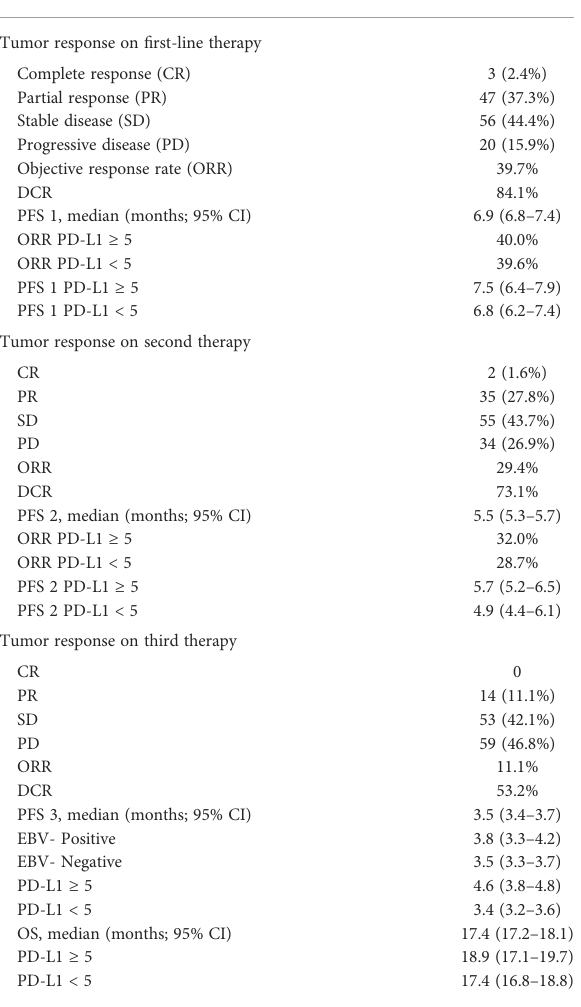
TABLE 2 Ef fi cacy of treatments.